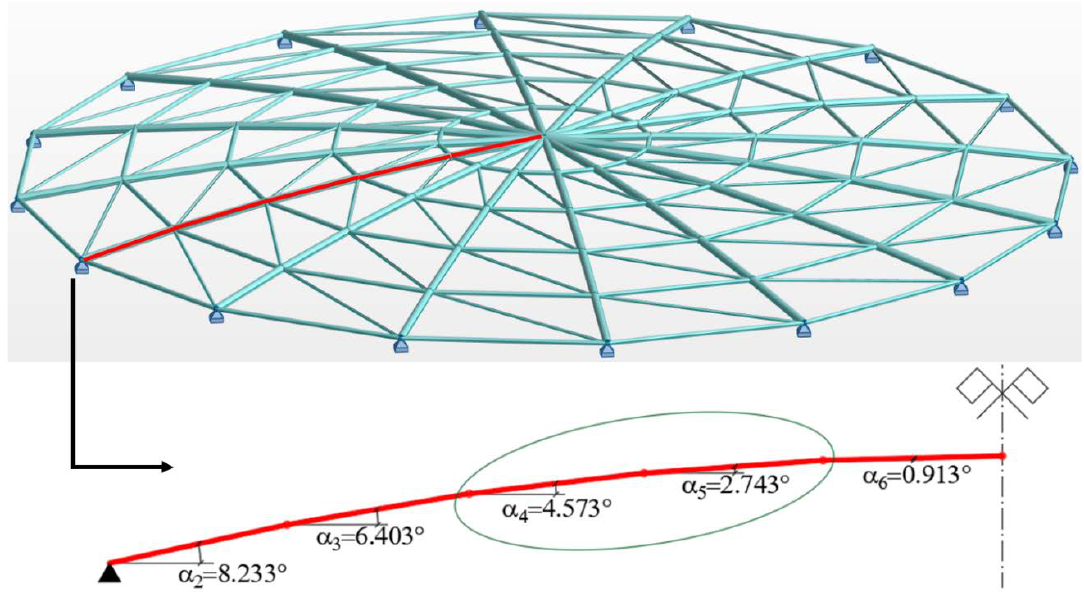
Figure 9. Example of shallow dome.